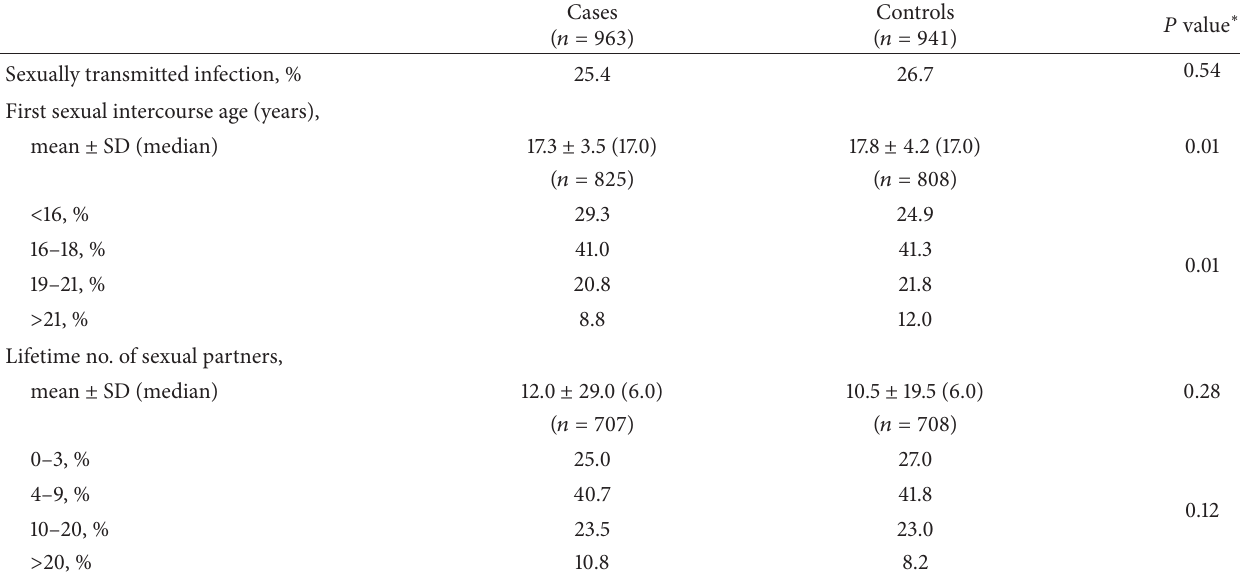
Table 2: Sexual behaviors among African-Barbadian men.